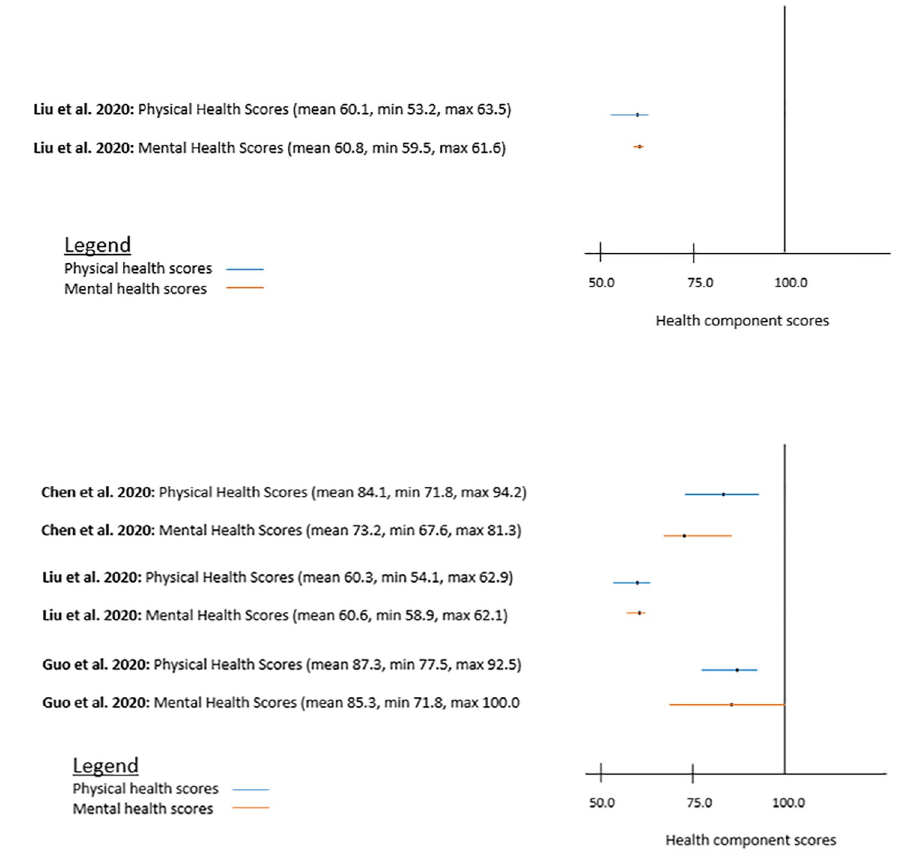
Fig 2. a. SF-36 physical and mental health components scores of Acute Covid. b. SF-36 physical and mental health components scores of Long Covid.